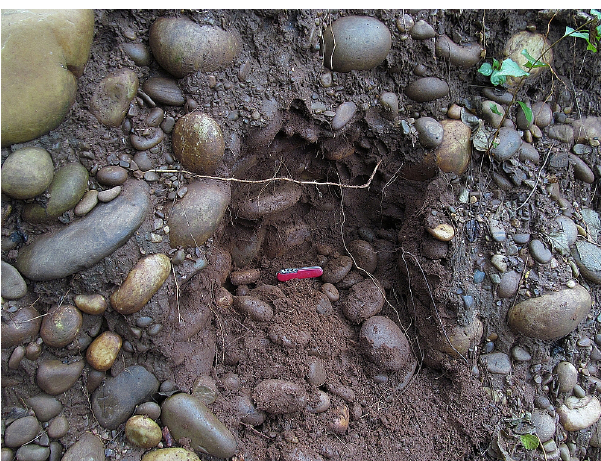
Figure A4. CDT4 – sample from poorly sorted fluvial pebble and cobble conglomerate terrace fill deposited during a single event. Sample is ∼ 3m below terrace surface and ∼ 80m above modern channel. OSL dated at 11080 ± 1960 years (Ray and Srivastava, 2010); 90mm long penknife for